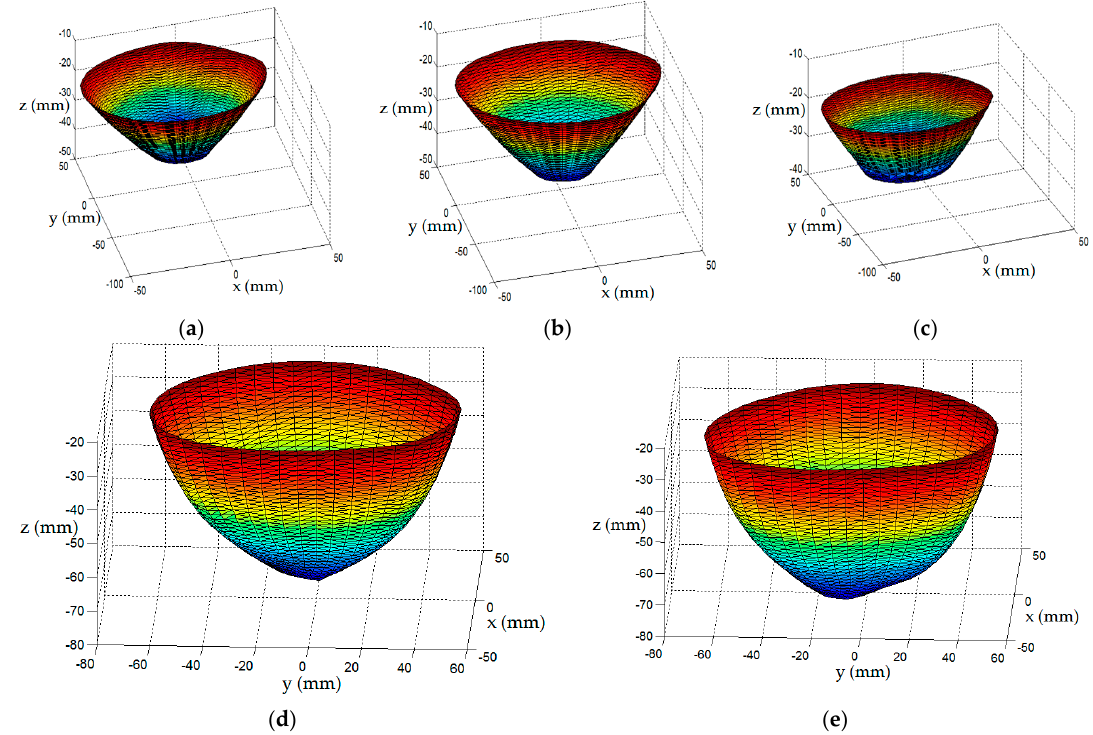
Figure 14. ( a ) Surface of left breast constructed from volunteer A. Surface reconstructed of same breast 4 weeks later, and 6 weeks later, ( b ), and ( c ), respectively. ( d ) Surface of left breast constructed from volunteer B and ( e ) surface of same breast 2 weeks later.